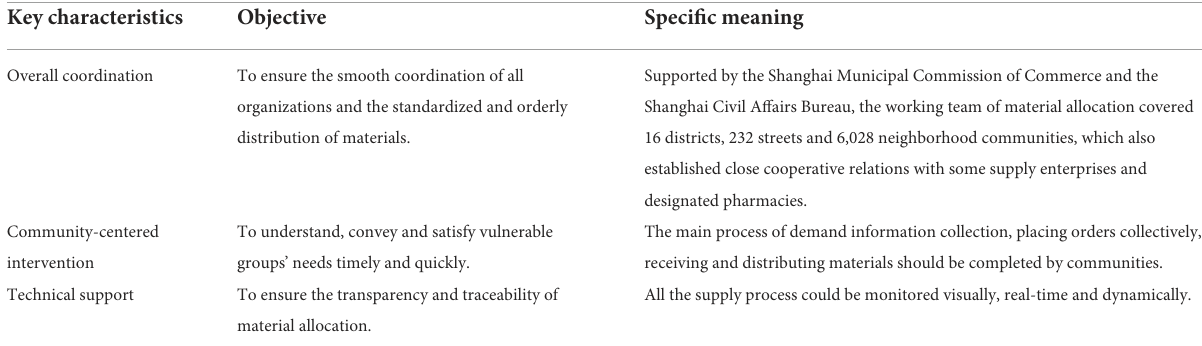
TABLE 2 Four key characteristics and essential functions of the Shanghai